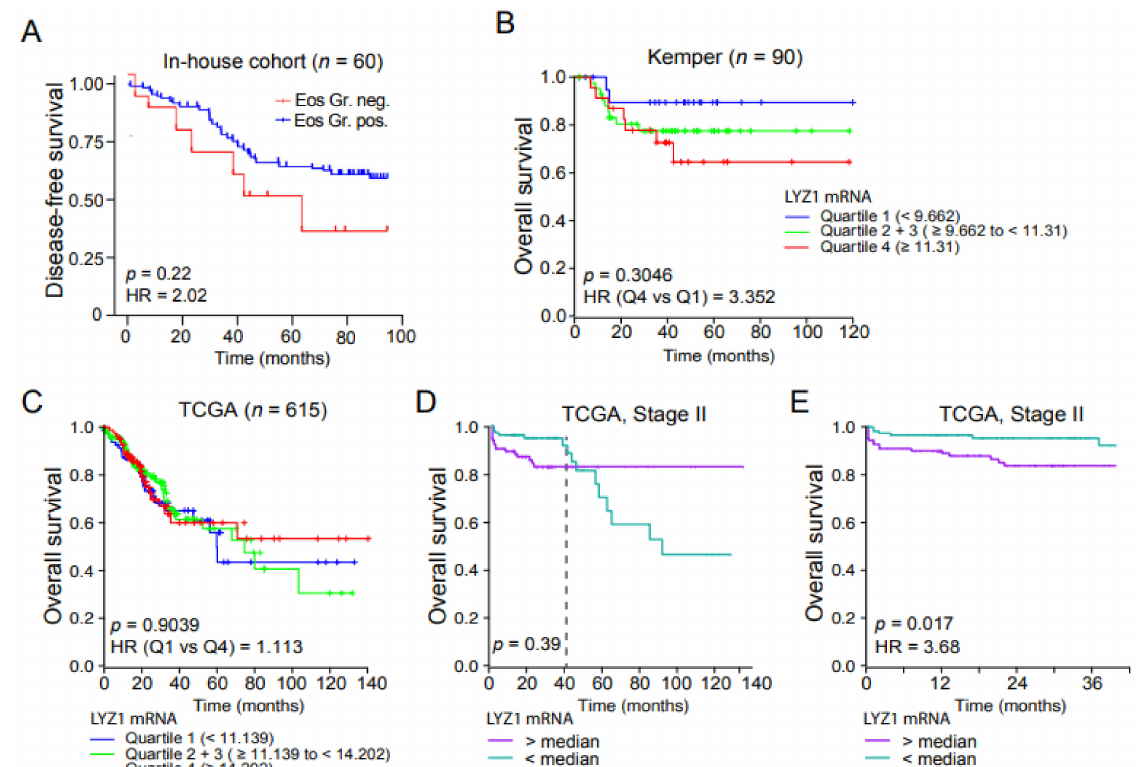
Figure 5. Presence of Paneth cells in the adenomas is indicative of poor prognosis. ( A ) Kaplan–Meier curves representing patients’ disease-free survival classified according to the presence of eosin-positive granules in the adenoma tissue from our in-house cohort of 60 colorectal cancer patients. ( B , C ) Kaplan–Meier curves representing patients DFS classified according to LYZ expression levels in patients from the Kemper ( B ) or TCGA ( C ) CRC datasets considering all stages. ( D , E ) Kaplan–Meier curves representing patients DFS classified according to LYZ expression levels in stage II patients from TCGA data set at 140 months ( D ) or 40 months ( E ) from diagnosis. We used Cox proportional hazards models for statistical Kaplan–Meier